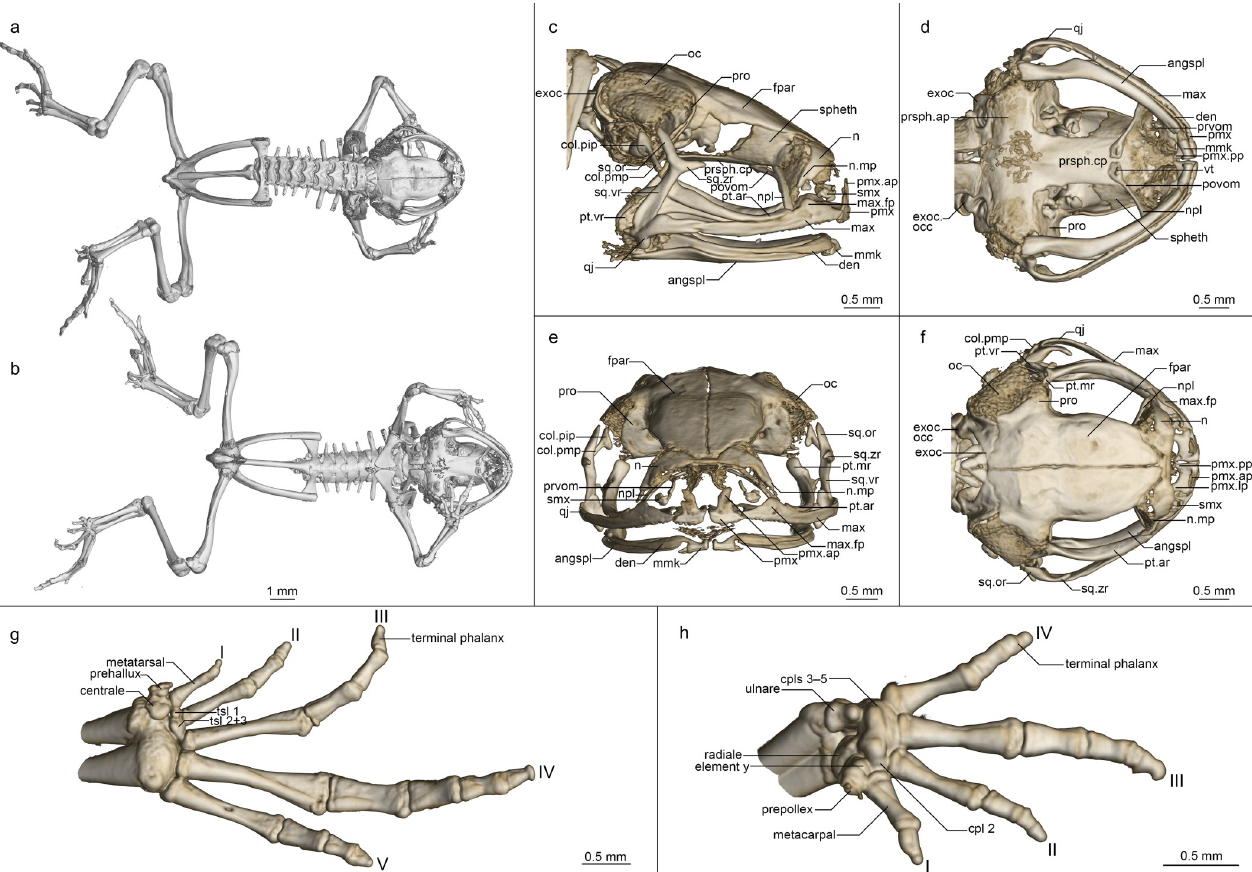
Fig 11. Osteology of Rhombophryne proportionalis sp. nov. holotype (ZSM 1826/2010). (a, b) Whole skeleton in (a) dorsal and (b) ventral view. (c-f) Skull in (c) lateral, (d) ventral, (e) anterior, and (f) dorsal view. (g) Foot in ventral view. (h) Hand in ventral view. For abbreviations, see Fig 6. Holotype description. Specimen in a good state of preservation, part of the right thigh removed as a tissue sample. Body somewhat rhomboid; head wider than long, narrower than body; snout rounded in dorsal view, squared in lateral view; nostrils directed laterally, not pro- tuberant, closer to eye than to tip of snout; canthus rostralis rounded, concave; loreal region flat, vertical; tympanum indistinct, round, about 57% of eye diameter; supratympanic fold dis- tinct, weakly raised, curving slightly from posterior corner of eye over tympanum toward axilla; tongue very broad, disc-like, posteriorly free, unlobed; maxillary teeth present; vomerine teeth present in two tiny patches either side of the midline; choanae rounded. Forelimbs slen- der; subarticular tubercles faint, single; outer metacarpal tubercle faint, paired; inner metacar- pal tubercle distinct, elongated; hand without webbing; first finger reduced, second and fourth short; relative length of fingers 1 < 2 = 4 < 3; finger tips not expanded. Hind limbs robust; TIBL 34% of SVL; lateral metatarsalia strongly connected; inner metatarsal tubercle thin and indis- tinct; outer metatarsal tubercle small and indistinct; no webbing between toes; first toe highly reduced, second toe short; relative length of toes 1 < 2 < 5 < 3 < 4; fifth toe distinctly shorter than third. Skin on dorsum smooth in preservative, without distinct dorsolateral folds. In life, the dorsal skin was smooth was scattered tubercles, and distinct ridges above the scapular region (Fig 10). Ventral skin smooth in preservative, granular in life.